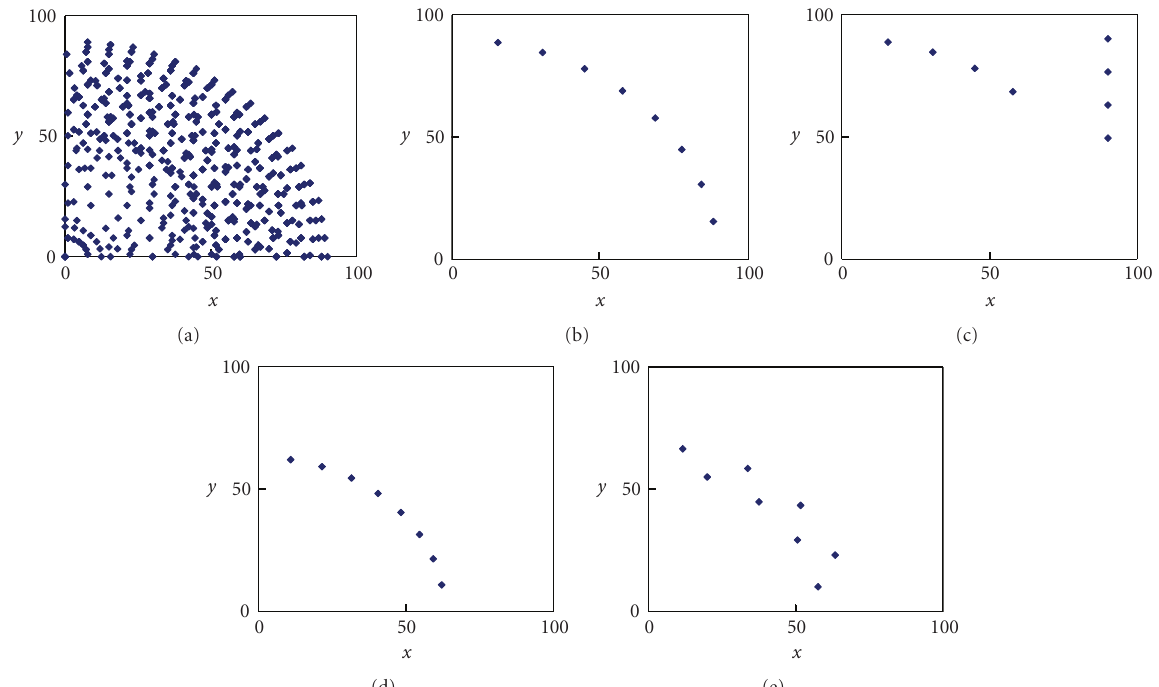
Figure 6: Distribution of end-e ff ector coordinates (a) for training data and for test data of (b) well-posed problem and a problem with (c) nonunique solution, (d) no solution, and (e) unstable solution.